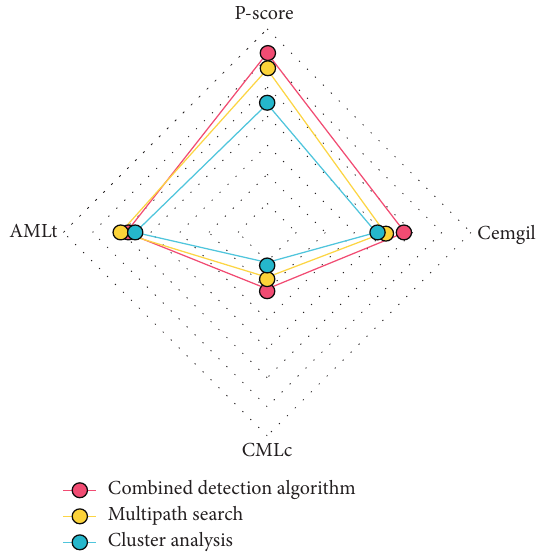
Figure 9: Comparison of evaluation index data of different